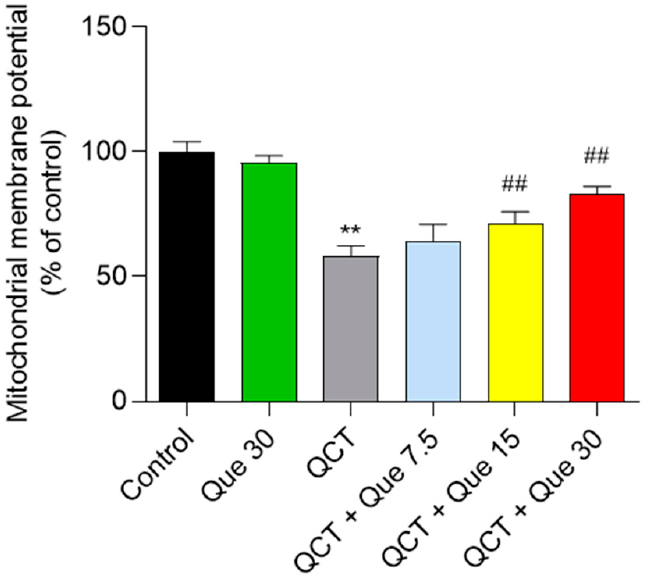
Figure 5. The effects of quercetin supplementation on QCT-induced loss of mitochondrial membrane potential (MMP) in L02 cells. All results were presented as mean ± SD ( n = 4 independent experiments). ** p < 0.01, compared to the vehicle control group; ## p < 0.01, compared to the QCT ‐ alone group. QCT, quinocetone; Que, quercetin.